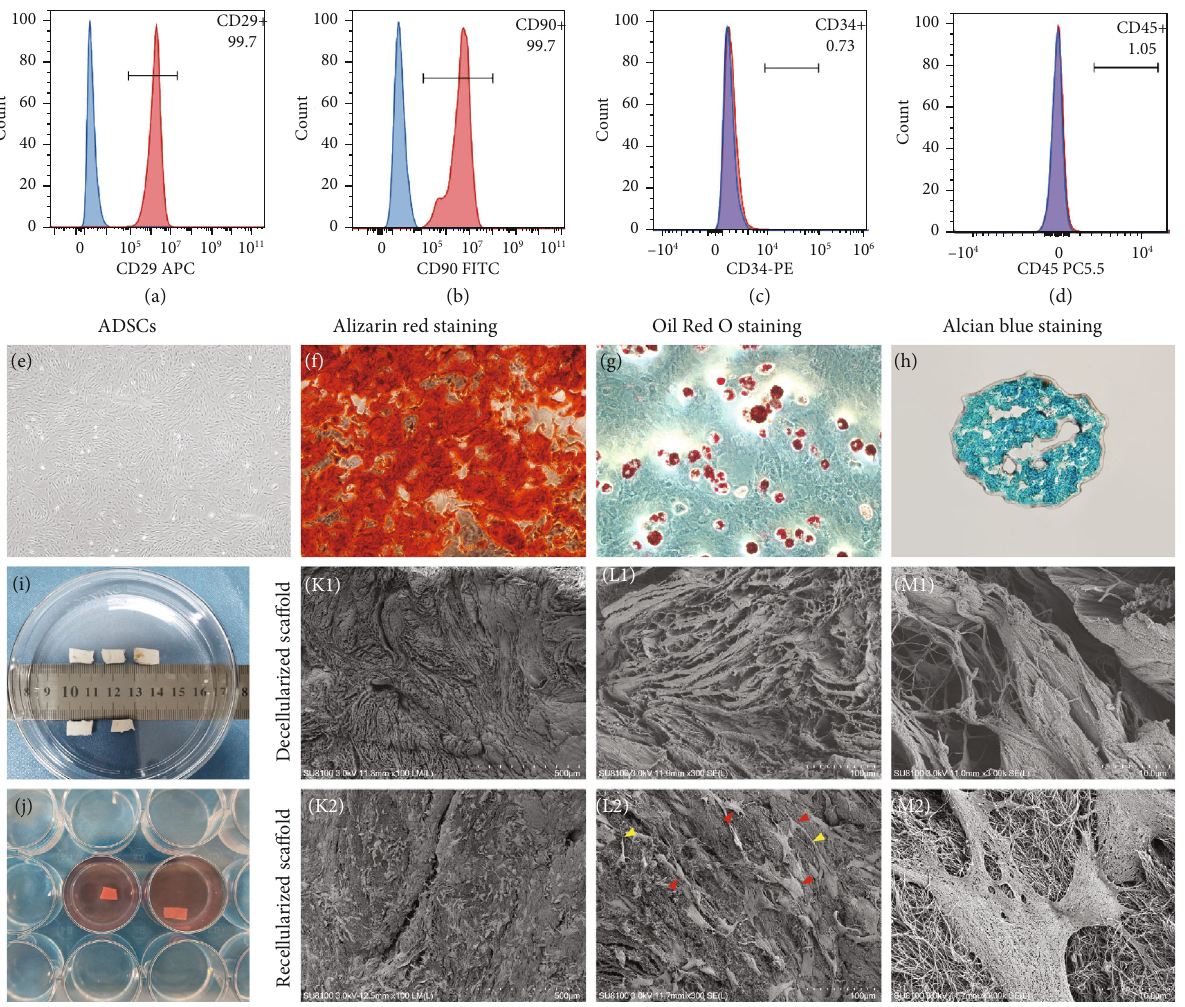
Figure 3: Evaluation of ADSCs and recellularized sca ff old. ADSCs were successfully isolated from rat adipose tissues. ADSCs highly expressed CD29 and CD90 but hardly expressed CD34 and CD45 detected by fl ow cytometry (a – d). ADSCs displayed fi broblast-like spindle shape (e, 4x). Calcium deposit was stained with Alizarin Red (f, 10x). Adipogenic vesicles were observed by Oil Red O staining (g, 20x). Glycosaminoglycan (GAG) in the cartilage matrix nodule was stained with Alcian blue (h, 20x). The decellularized sca ff olds were dried by an experimental vacuum freeze dryer and sliced to pieces (i) and then recellularized (j). The structures of decellularized sca ff old (K1-M1) and recellularized sca ff old (K2-M2) were observed via scanning electron microscopy at di ff erent magni fi cations. After RC, ADSCs fi lled the gaps shown in the decellularized sca ff old while displaying out-grown morphology. Red arrows indicate ADSCs. Yellow arrows indicate cellular extension and a network between ADSCs. Scale bars represent 500 μ m (k), 100 μ m (l), and 10 μ m (m),